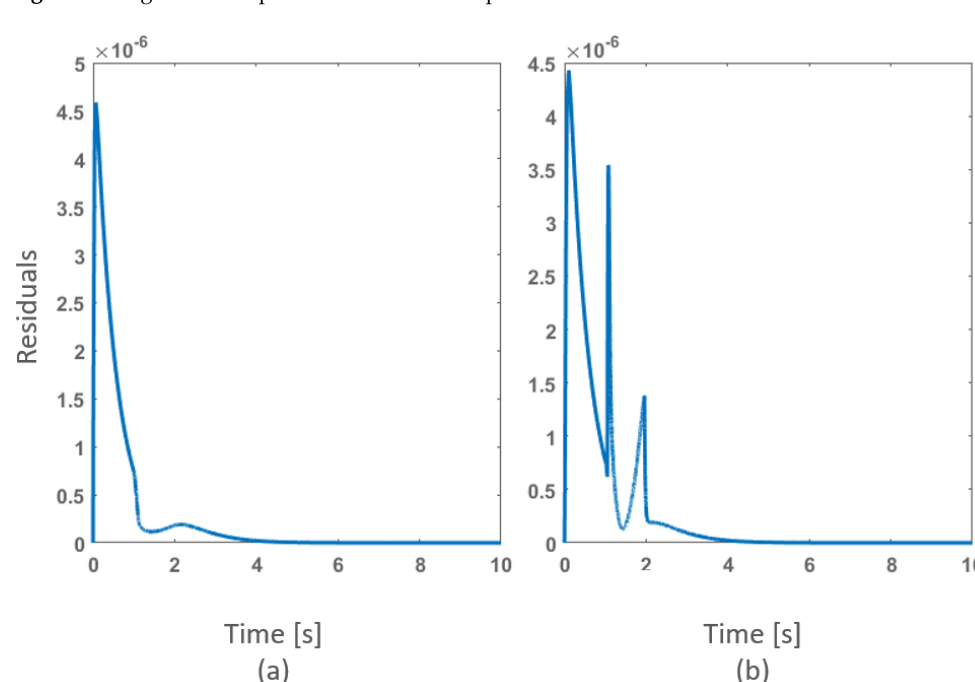
Figure 9. Estimation residuals for ( a ) I p and ( b ) I q